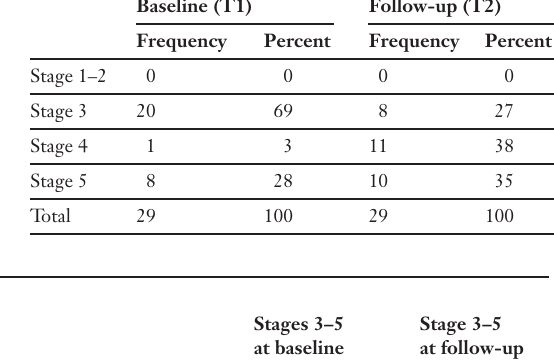
Time spent on regu- lar physical activity during one week, at baseline and after